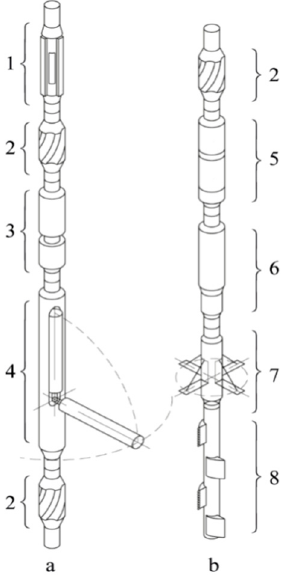
Figure 5. Schemes of bottomhole assemblies: ( a ) circular and conical recesses drilling and ( b ) rock mass destruction and grinding; 1—anchor, 2—centralizer, 3—turning gear, 4—special tool with deflecting bit, 5—shock absorber, 6—mechanical vibrogenerator (jar) of longitudinal oscillations, 7—blade raising device, 8—reamer with fixed blades.